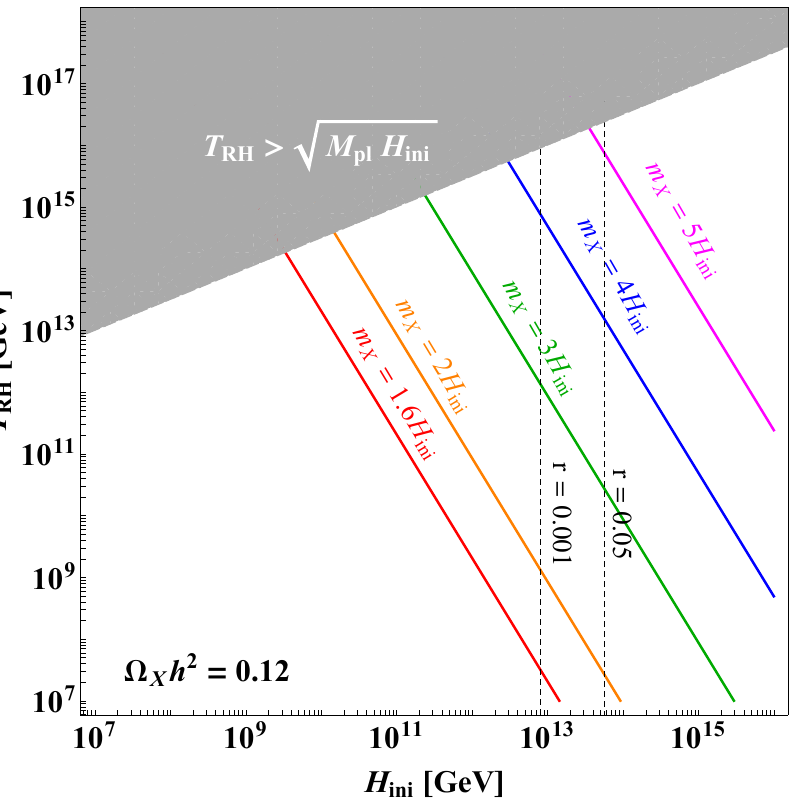
Figure 3 . The parameter space that in(cid:13)ation can produce enough DM according to eq. 2.21. The gray region is forbidden by energy